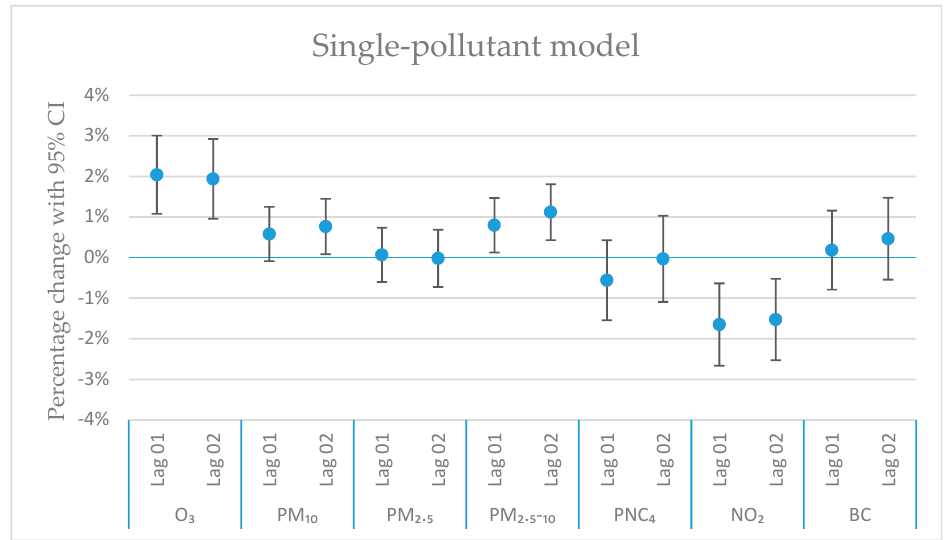
Figure 4. The estimated change in daily mortality (with 95% CI) for an IQR increase in concentration (lag01 and lag02) to the different air pollutants in a single-pollutant model.